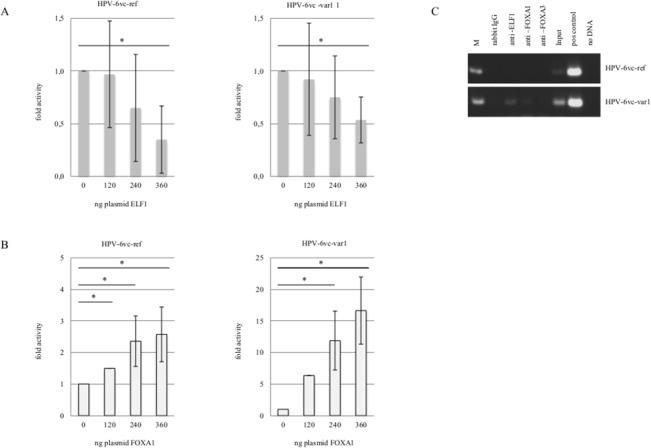
Binding and activity of ELF1 and FOXA1 to HPV-6vc-ref and HPV-6vc-var1.Luciferase reporter assay for (A) ELF1 and (B) FOXA1. (C) Amplification of LCR fragments following chromatin immunoprecipitation (ChIP) using primers surrounding nucleotide position 7626 that differs among HPV-vc-ref and HPV-6vc-var1 variants. Input-nonimmunoprecipated samples.